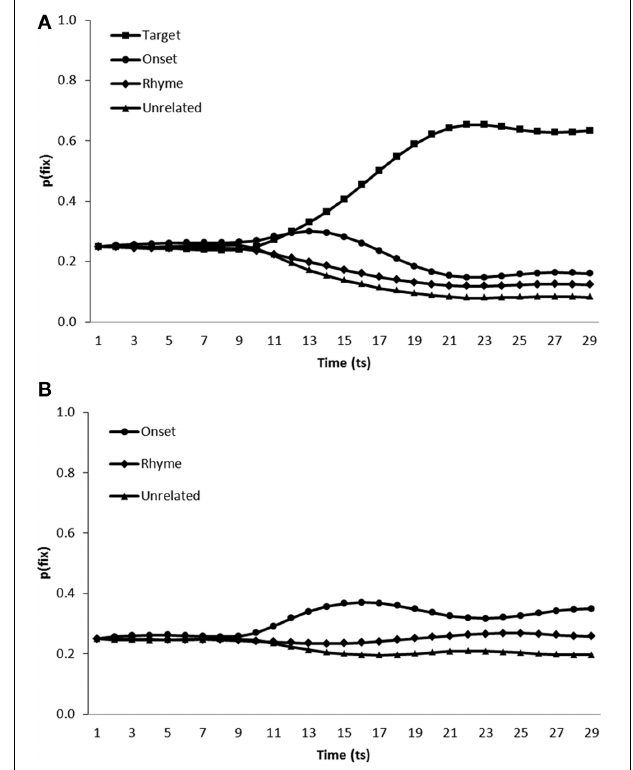
FIGURE 7 | Proportion of fixations [p(fix)] directed toward items within scenes containing (A) a target, a near semantic neighbor (SemNear), a far semantic neighbor (SemFar) and an unrelated distractor, (B) a near semantic neighbor (SemNear), a far semantic neighbor (SemFar) and two unrelated distractors; by the model trained in a noisy learning environment.